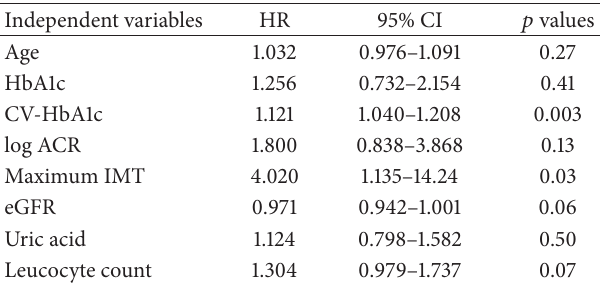
Table 3: Cox regression analyses for exacerbation of chronic kidney disease in patients with type 2 diabetes and preserved kidney